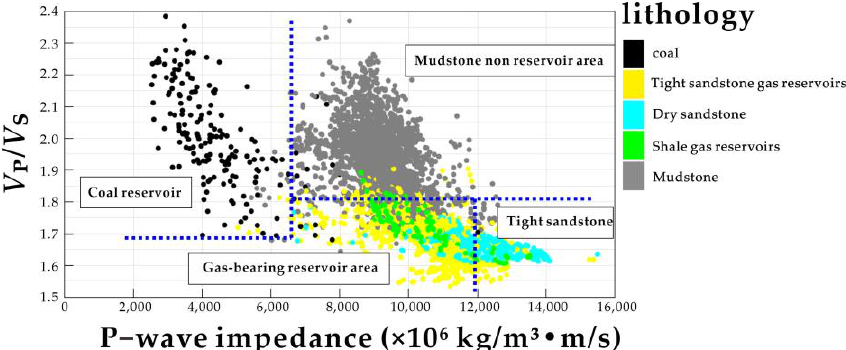
Figure 4. The cross plot of P-wave impedance-P-wave and S-wave velocity ratio after the correction of petrophysics (coal bed is relatively low wave impedance, high P-wave, and S-wave velocity ratio; sandstone gas bed is medium-high wave impedance, low P-wave, and S-wave velocity ratio; dry sandstone bed is relatively high wave impedance, low P-wave, and S-wave velocity ratio; shale gas reservoir is medium-low P-wave impedance, medium-low P-wave velocity ratio).